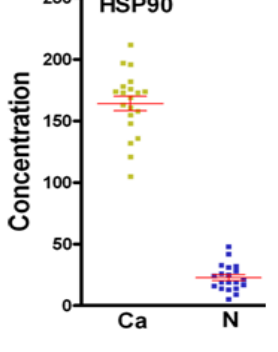
Figure 3. Levels of the potential biomarker HSP90 in the serum of 20 HCC patients and HSP 90 in serum levels of HCC patients (164.7 ± 6.566 ng/mL) were significantly